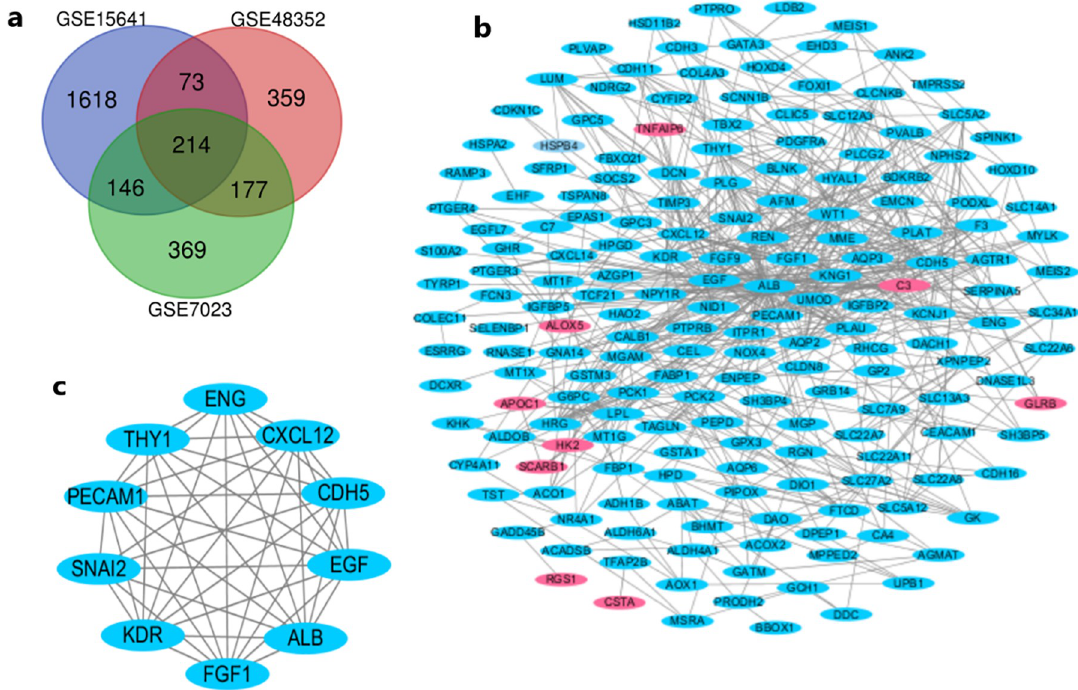
Fig 1. Venn diagram, PPI network and most significant module of the DEGs. (a) DEGs were selected from the mRNA expression profile datasets GSE7023, GSE48352 and GSE15641 with the criteria of |log 2 FC (fold change) | > 1 and FDR adjusted P value < 0.05. A total of 214 genes overlapped among the 3 datasets. (b) STRING and Cytoscape were used to construct a PPI network of the DEGs. (c) The MCODE plug-in in Cytoscape was used to identify the most significant module in the PPI network; this module contained 10 nodes and 43 edges. Red represents upregulated genes, and blue represents downregulated